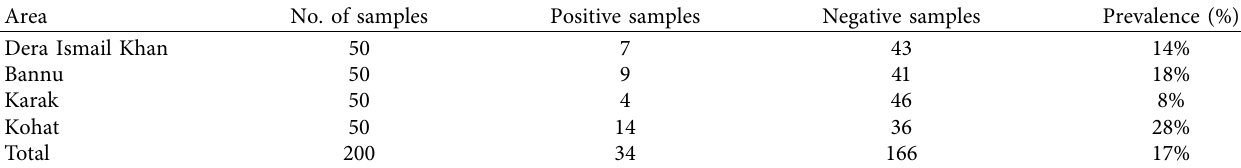
Table 1: Seroprevalence of Mycoplasma capricolum subsp. capripneumonaie by cELISA in southern areas of Khyber Pakhtunkhwa.